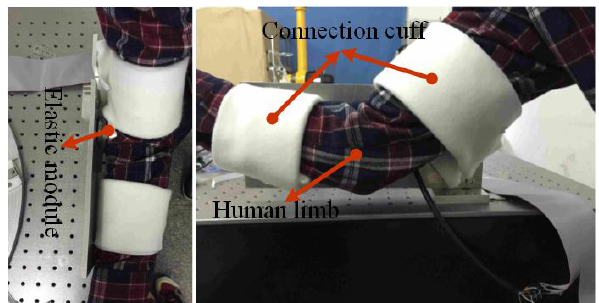
Figure 10. HRI measurement experiment on human upper limb. The connection is used to fasten the elastic module on the human limb. The signals of the magnetic encoder are transferred back to the PC through the PMAC.